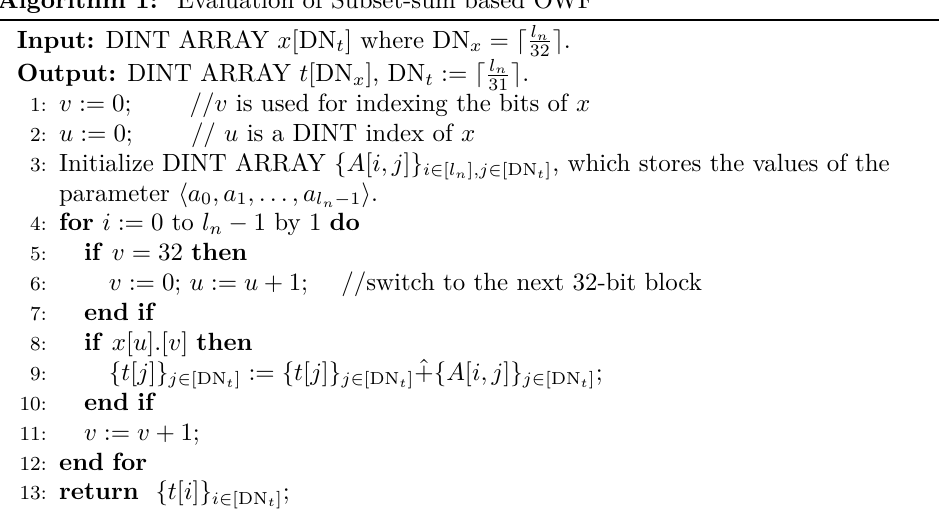
Algorithm 1: Evaluation of Subset-sum based